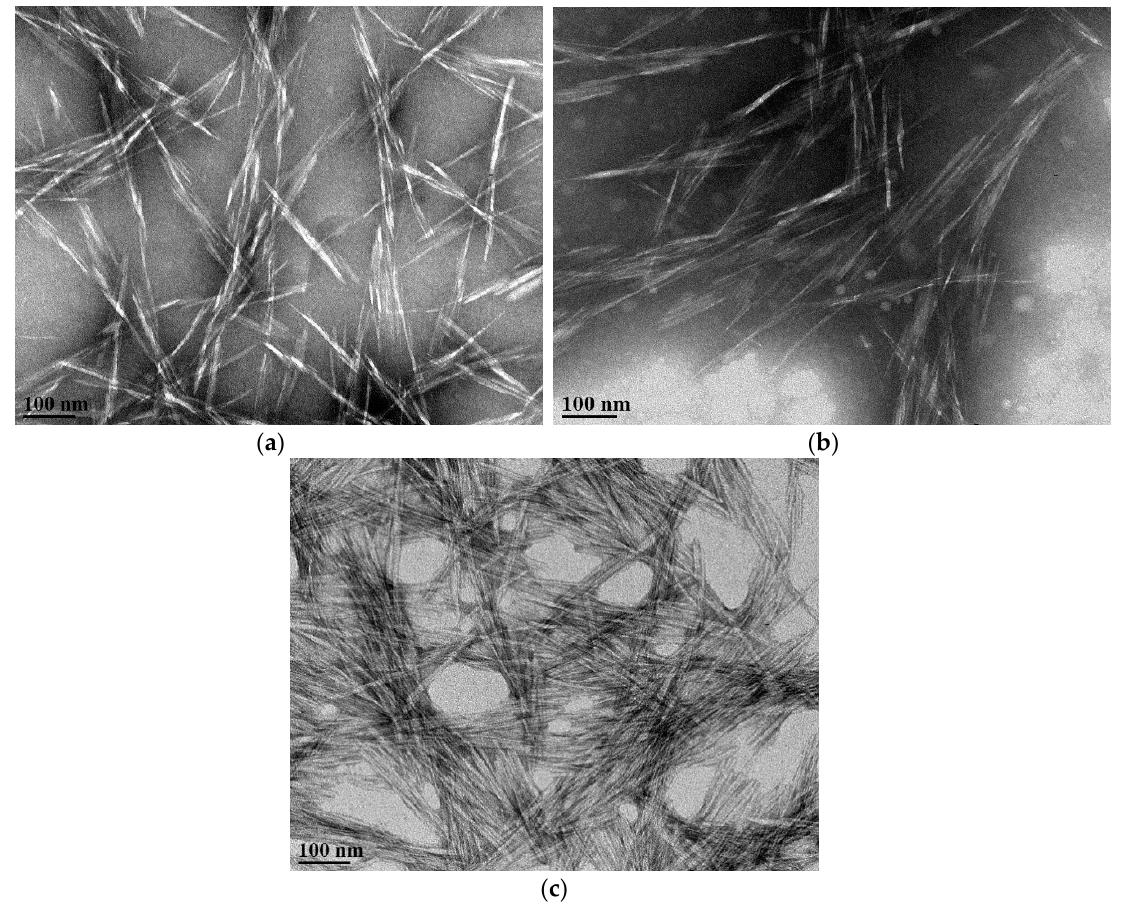
Figure 5. TEM images of cellulose nanocrystals produced from acid hydrolysis of ( a ) mock-treated wood pulp ( b ) Endo-CBD+ (1.0 U/g of pulp loading)-treated wood pulp, and ( c ) Endo-CBD − (1.0 U/g of pulp loading)-treated wood pulp.